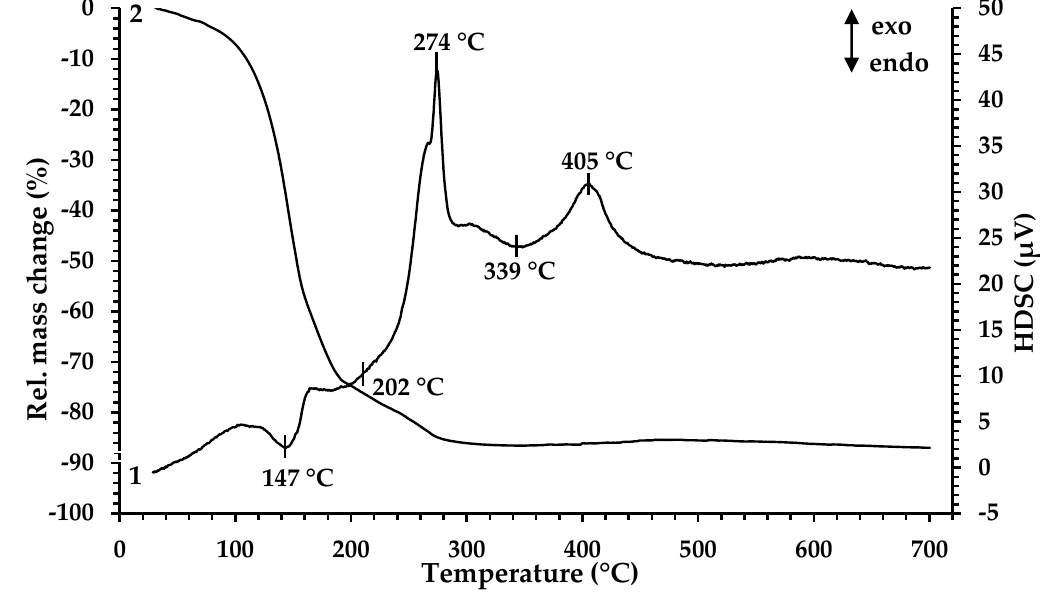
Figure 1. Thermal analysis of Fe-containing extract (precursor 1): 1 — HDSC, 2 — TG.